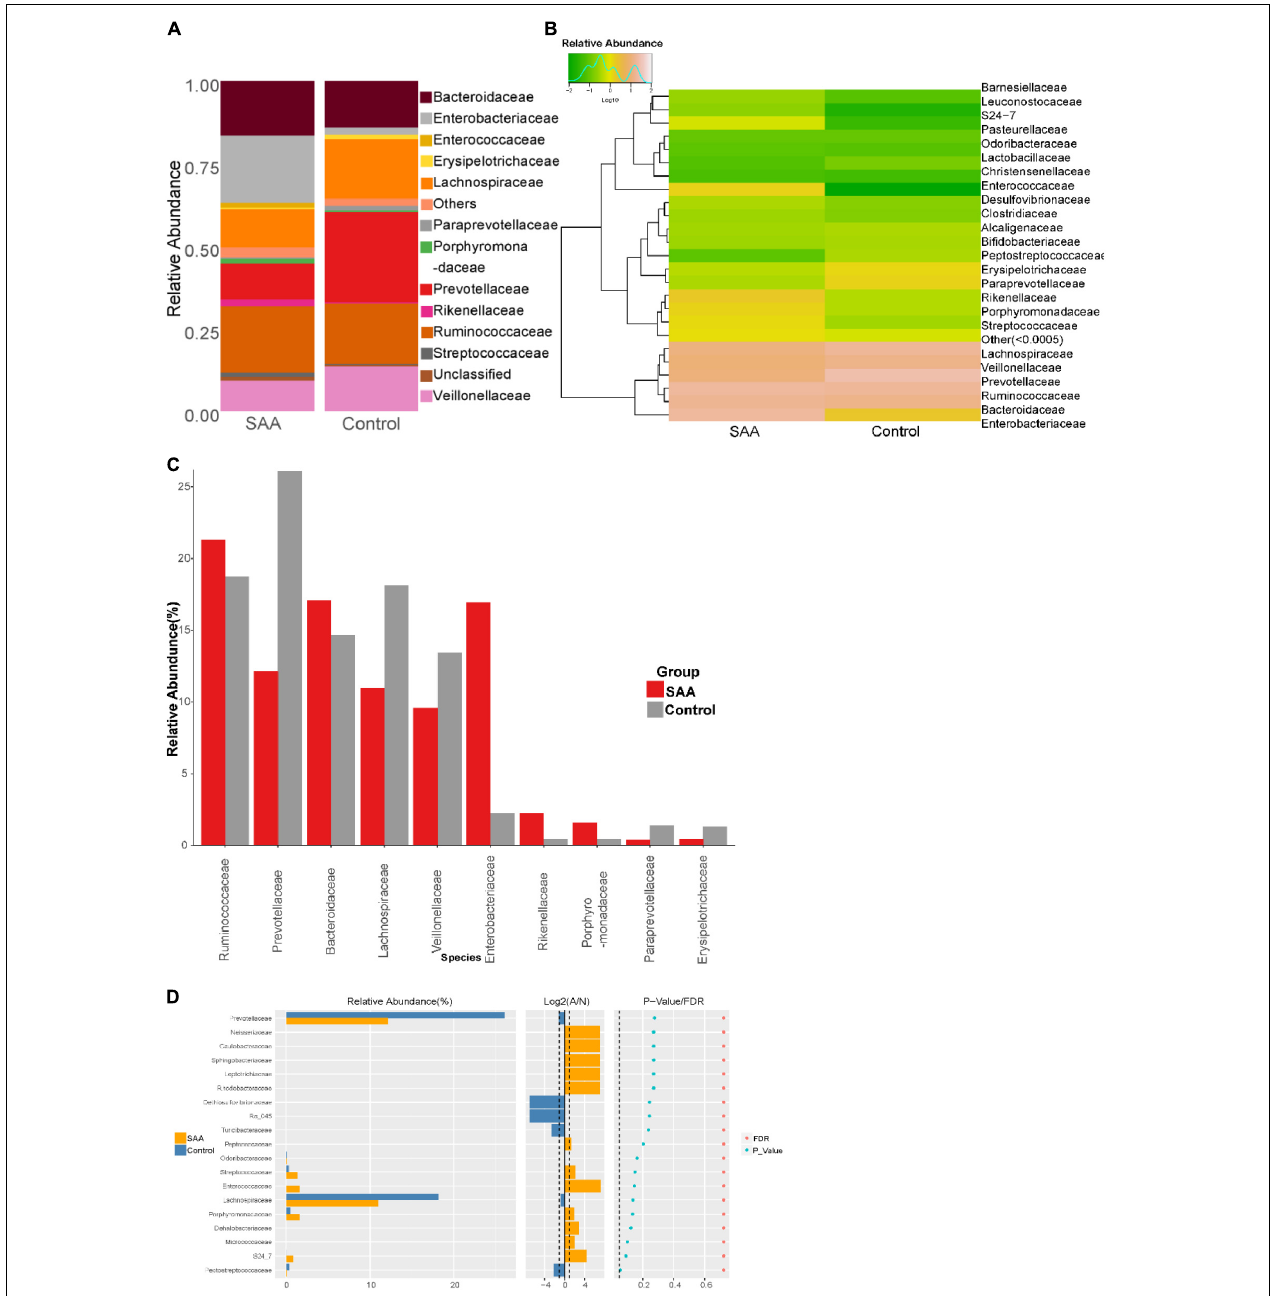
FIGURE 6 | Intestinal microbial compositions of the SAA and control groups at the family level. (A) Bar plot, (B) heatmap, (C) top 10 most abundant species, (D) Wilcoxon rank-sum test